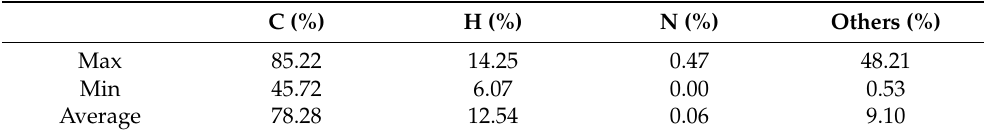
Figure 2. Chemical composition (wt.%) of each sample of polymeric films: ( a ) C, H and others; ( b ) N. Table 1. Maximum, minimum and average values of wt.% C, H, N and other elements of the set of analysed polymeric films.